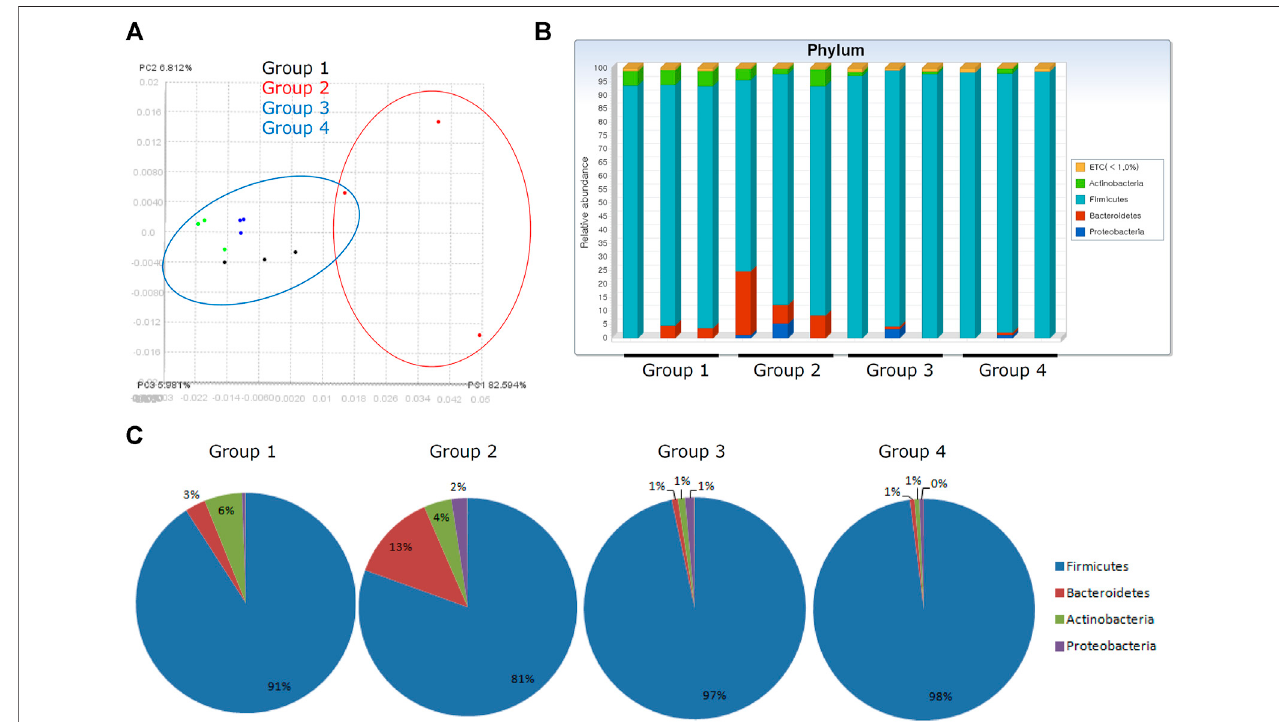
FIGURE7| Fecalmicrobiotachangesaccordingtogroups. (A) Principalcoordinateanalysis(PCoA)showingde fi nitediscriminationofmicrobiotaaccordingtoPD- MSC administration, that is, between PD-MSC – treated and non-treated groups under H. pylori – induced CAG. (B) Phyla changes showing bar display. (C) Phyla level change. (D) Genus level changes with bar display. (E) Heatmap with microbiota nomination.